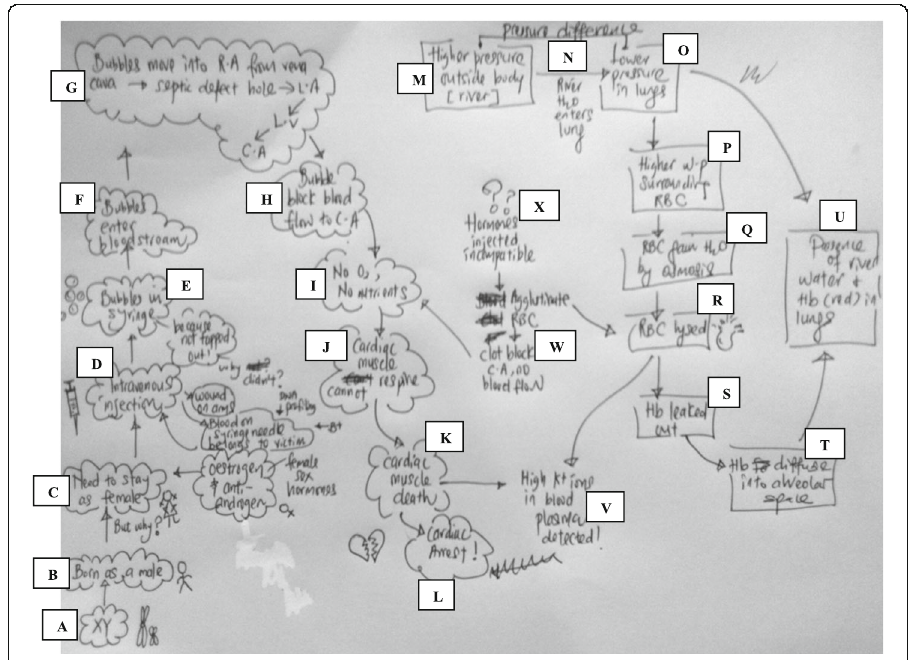
(refer to point C on the mind map) … because born as a male (refer to point B on the mind map) … XY in karyoptype (refer to point A on mind map) ” .